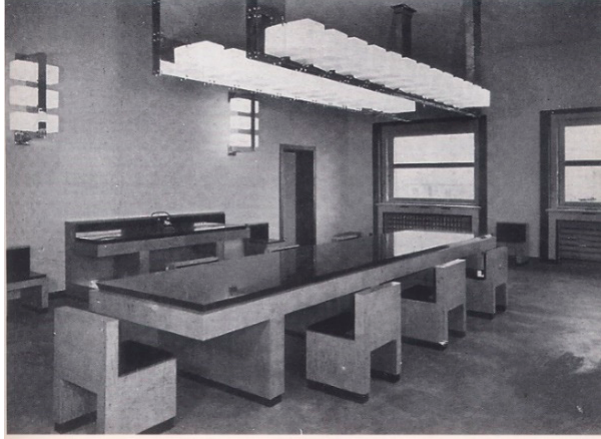
Figure 4. Palazzo Gualino offices. Meeting room. Furnishings in Buxus. Photo from (Ponti 1930).